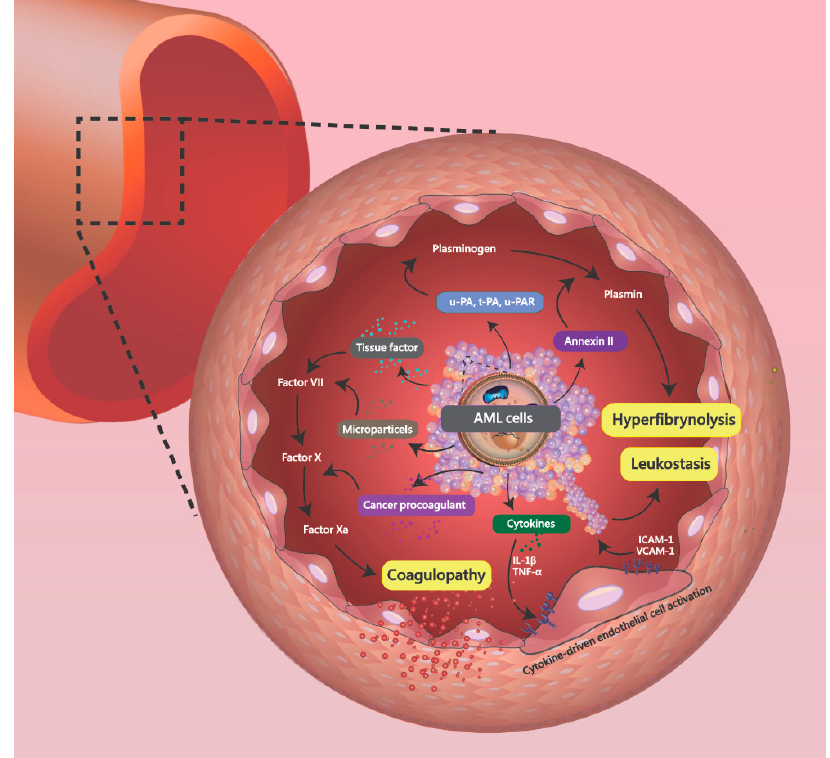
Figure 2. In an APL model, the acute myeloid leukemia (AML) cell produces microparticles (MPs), tissue factor (TF), and cancer procoagulant (CP), which act on the coagulation cascade to promote plasminogen into plasmin, causing hyperfibrinolysis. Various inflammatory cytokines from